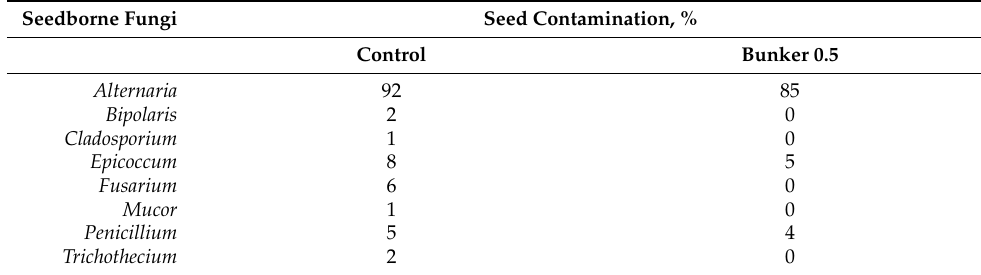
Table 6. Contamination of seeds with